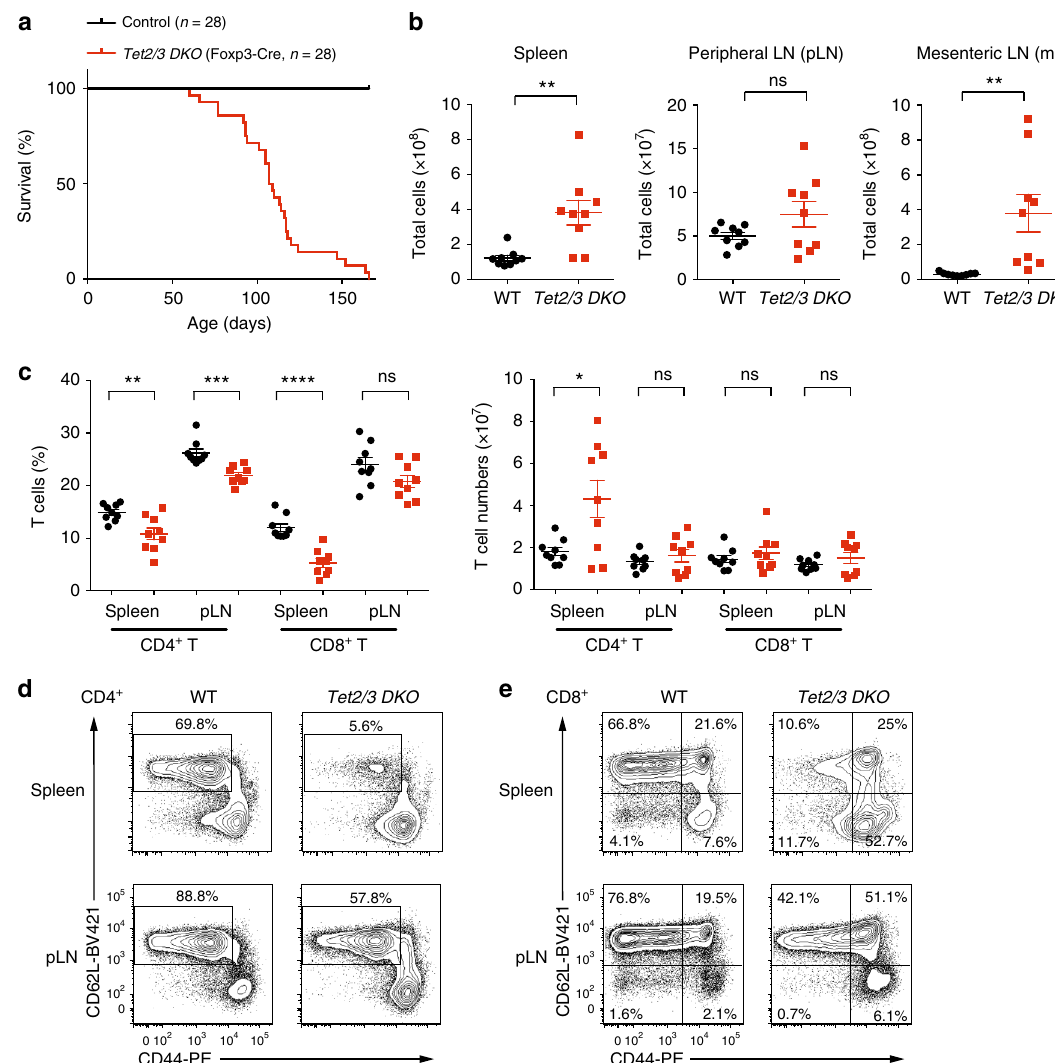
Fig. 1 Phenotypic analysis of mice with Treg-speci fi c deletion of Tet2 and Tet3 . a Survival curves for control WT and Tet2/3 fl / fl Foxp3 Cre DKO mice ( n = 28). b Total cell numbers in spleen, peripheral lymph nodes (pLN) and mesenteric lymph nodes (mLN) of WT and Tet2/3 fl / fl Foxp3 Cre DKO mice (13-16 weeks old, n = 9). c Percentages ( left panel ) and cell numbers ( right panel ) of CD4 + and CD8 + T cells in the spleen and pLN from WT and Tet2/3 fl / fl Foxp3 Cre DKO mice (13 – 16 weeks-old, n = 9). d Representative fl ow cytometry analysis of CD62L and CD44 expression in CD4 + Foxp3 - T cells from spleen ( upper panels ) and pLN ( lower panels ). e Representative fl ow cytometry analysis of CD62L and CD44 expression in CD8 + T cells from spleen ( upper panels ) and pLN ( lower panels ). Statistical analysis was performed using two-tailed unpaired student ’ s t test (* P < 0.05, ** P < 0.01, *** P < 0.001, **** P < 0.0001). Error bars show mean ± s.d. from at least three independent